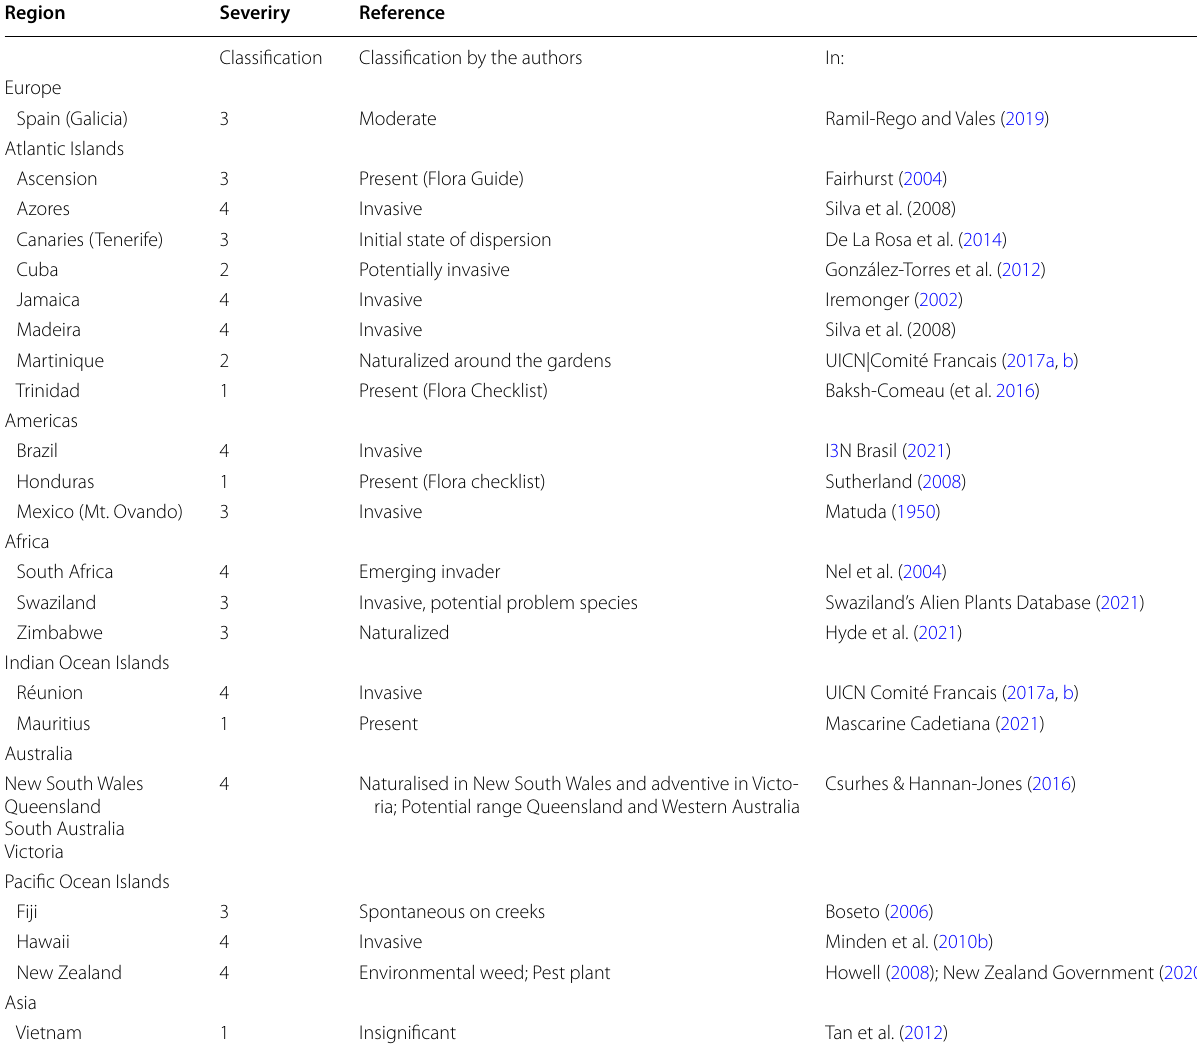
The species status in each region is here classified as: 1. Escaped from cultivation; 2. Escaped from cultivation and potentially invasive; 3. Invasive process started; 4. Invasive process